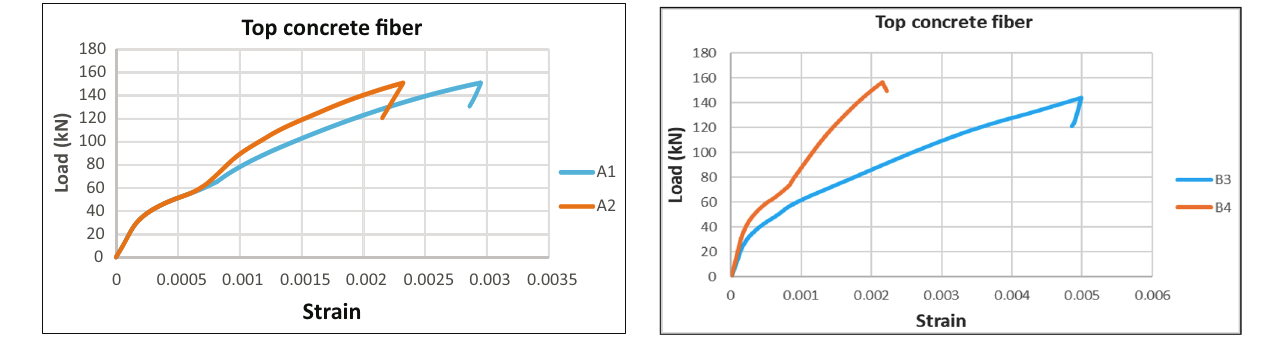
Figure 7: Strain in top concrete fi ber for specimens beams A1 and A2.